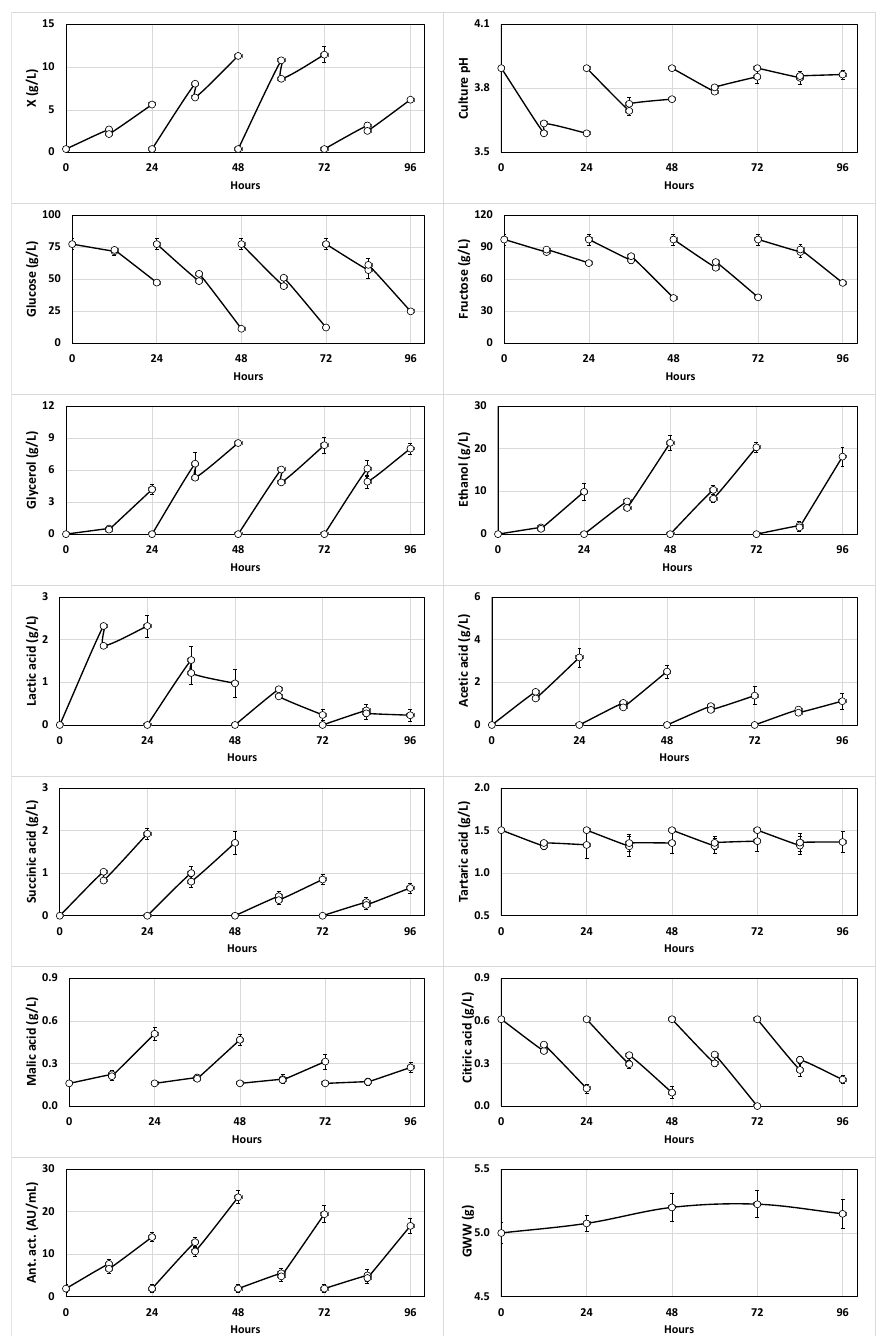
Figure 1. Kinetics of growth (X), culture pH, glucose, fructose, alcohols (glycerol and ethanol) and organic acids (lactic, succinic, tartaric, malic and citric); antibacterial activity (Ant. act.); and grain wet weight (GWW) in the 24-h fed-batch subcultures of red table grape juice at initial pH 3.99 fermented with kefir grains. The different subcultures were fed with fresh juice at 12, 36, 60 and 84 h, respectively.